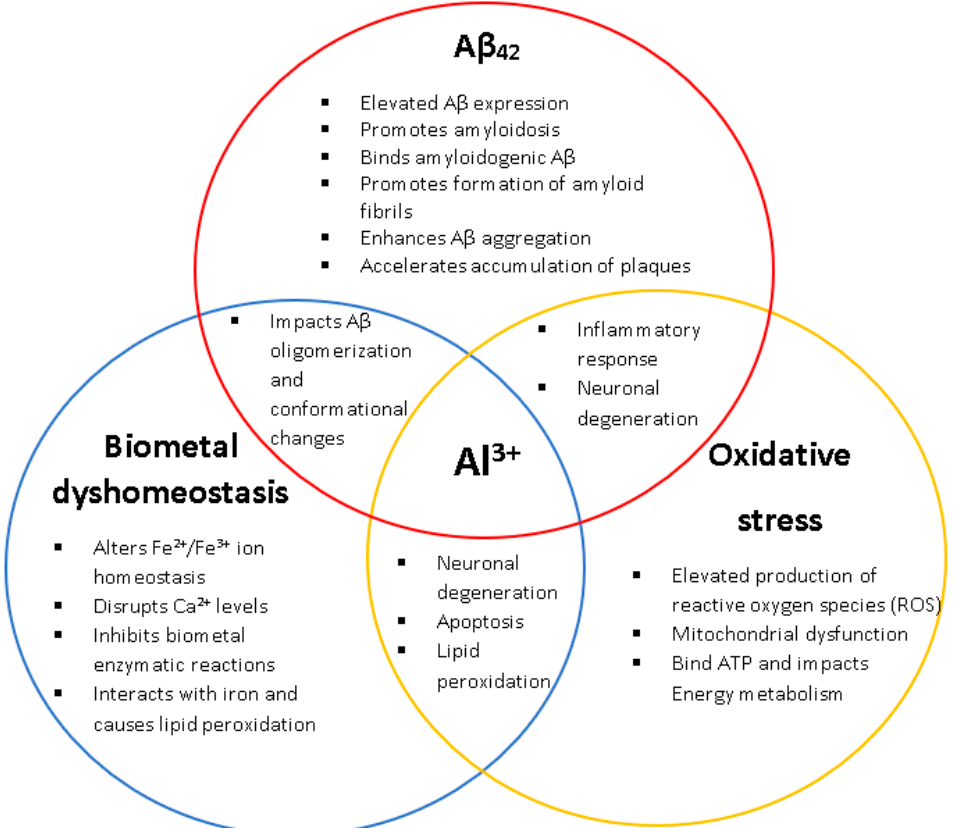
Figure 1. The biological relationships and impacts Al 3+ has on the characteristic hallmarks of Alzheimer’s disease (AD) (amyloid beta, biometal dyshomeostasis, and oxidative stress). Al 3+ has been experimentally shown to induce all key pathological events associated with AD, at multiple levels.